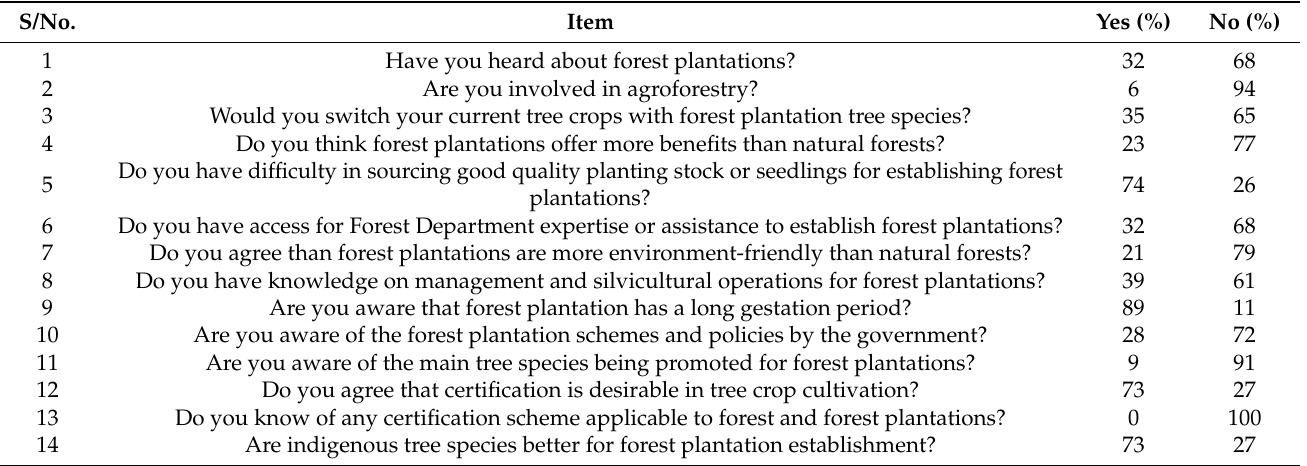
Table 3. Level of Awareness and Knowledge of Forest